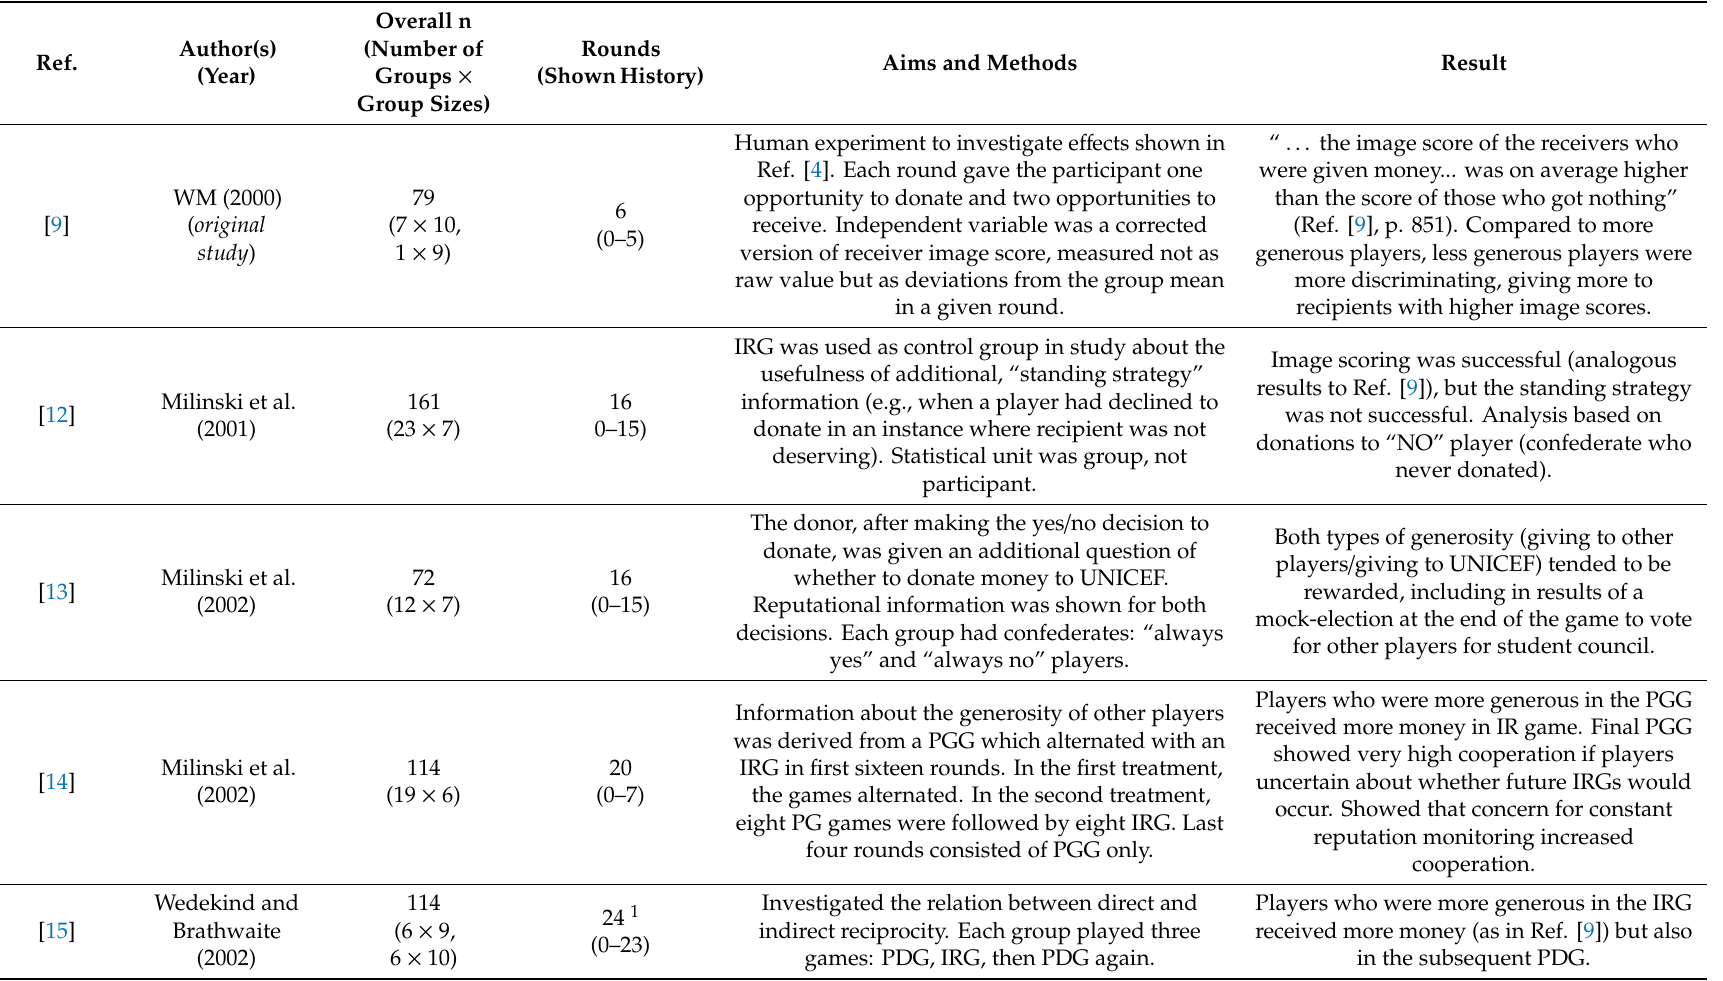
Table 1. List of replications, plus original and current study. Abbreviations: WM = Wedekind and Milinski; IRG = indirect reciprocity game; PGG = public goods game; PDG = prisoner’s dilemma game; CAG = competitive altruism game; UNICEF = United Nations Children’s Fund.